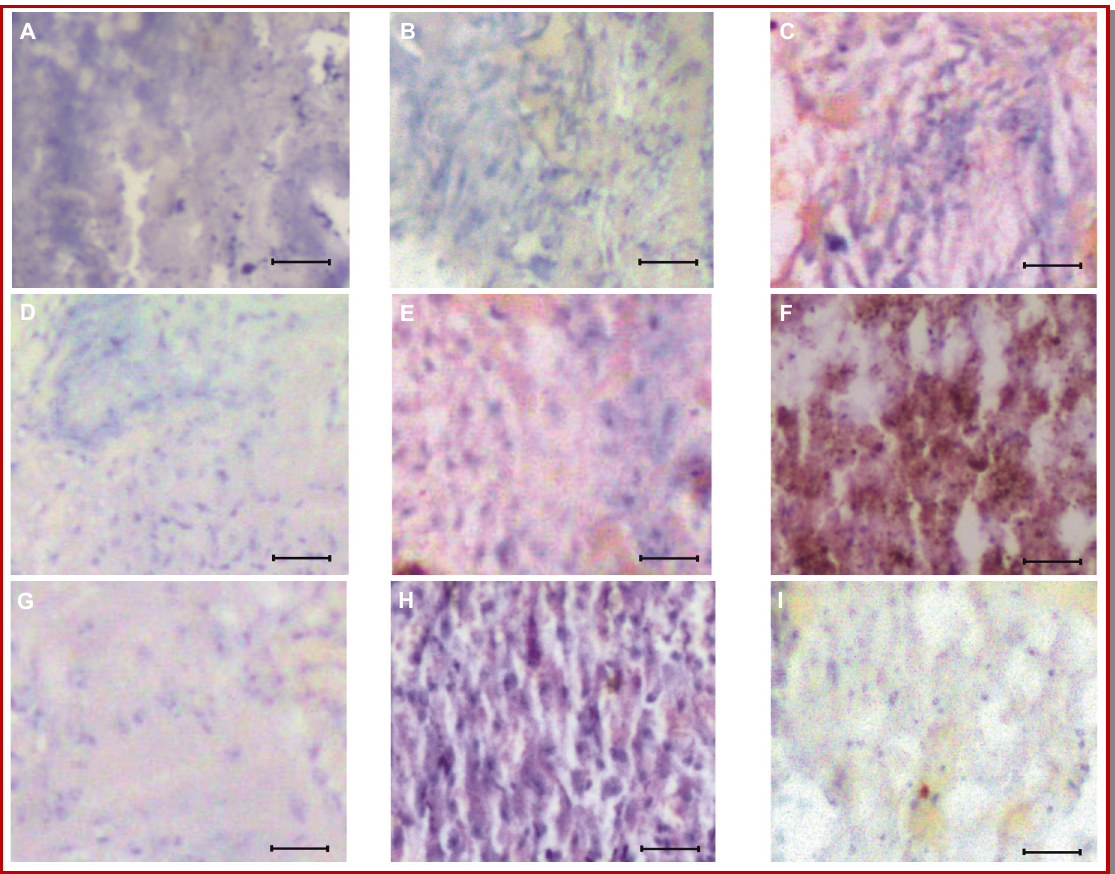
Figure 2: Comparative analysis of P2X7R, apoptotic and CD133 expression in normal and acute kidney injury tissue. Normal mice kidney shows P2X7R expression ( A). P2X7R expression starts to elevate on day 2 of acute kidney injury (B). High expression of P2X7R in advance stage of acute kidney injury (C). Control tissue without apoptotic signal (D). Moderate apoptotic signals on day 2 of acute kidney injury (E). Highly elevated expression of apoptotic protein on day 2 of acute kidney injury (F). Expression of renal stem cell specific protein in normal tissue (G). Elevated CD133 expression in initial damage of acute kidney injury on day 2 (H). Significantly down-regulated expression of CD133 in severe damage condition of acute kidney injury on day 4 (I). Scale Bar